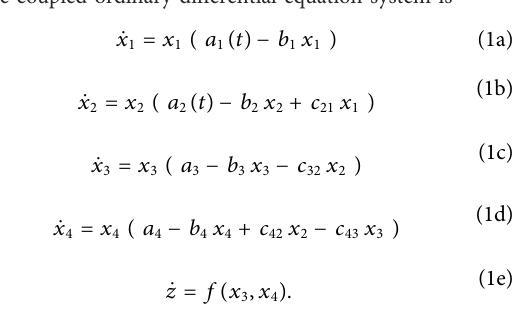
FIGURE 1 Simpli fi edsignalingpathwayformuscleadaptationpresented by Schiaf fi no and Mammucari (2011). IGF1 activates AKT, AKT activates mTOR and inhibits FOXO, FOXO inhibits mTOR and promotes atrophy, mTOR promotes